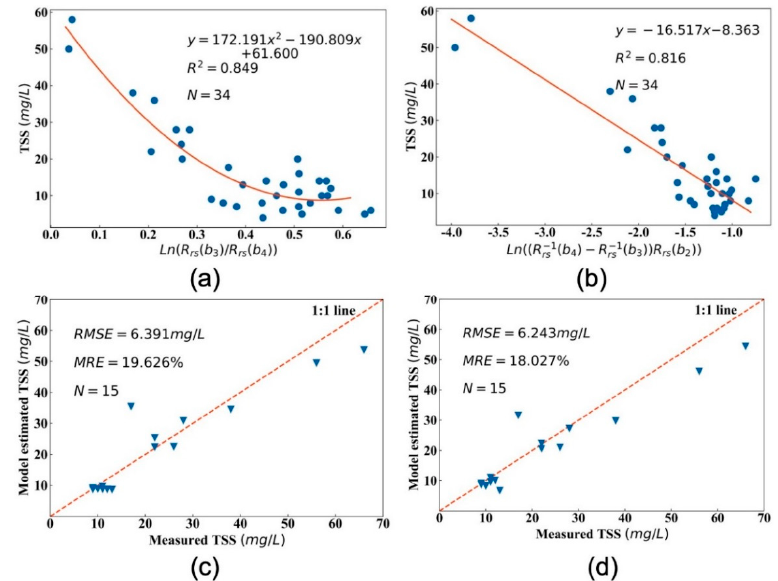
Figure 2. The calibration and validation of the TSS remote sensing estimation model between simulated OLI-based R rs and in situ measurement data are shown in the figure, where ( a ) shows the model calibrated by the band ratio algorithm, and ( b ) shows the model of the three-band algorithm. Plots of measured vs. model-estimated TSS in Hedi Reservoir with a 1:1 fit line (red dotted line), where ( c ) is the result of validating the band ratio model, and ( d ) is the validation result of the three-band model.